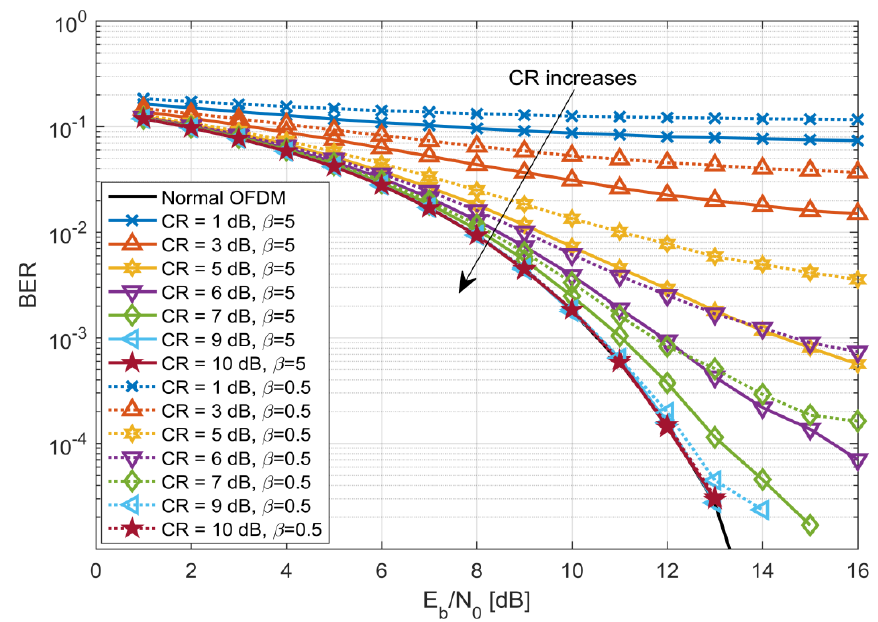
Figure 16. Bit Error Rate (BER) performance of the PC method with variable CR, N = 64, and the 4-QAM modulation over the Additive White Gaussian Noise (AWGN) channel.